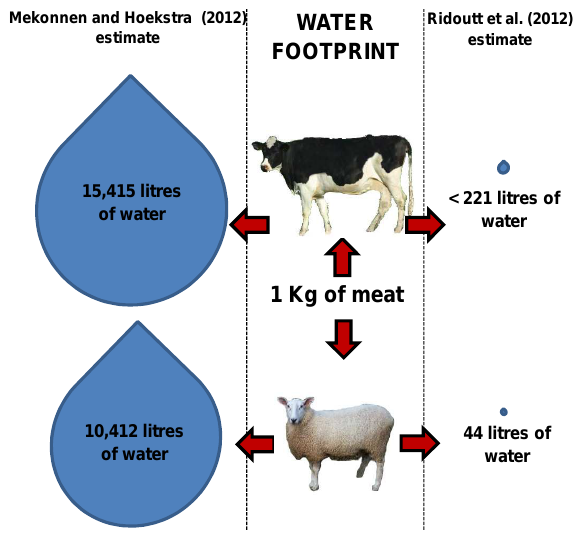
Figure 3. A comparison of the water footprints for beef and lamb calculated by Mekonnen and Hoekstra (2012a) and Ridoutt et al. (2012a,b), illustrating clearly how different methodological ap- Figure 3: A comparison of the water footprints for beef and lamb calculated by Mekonnen 16 proaches for calculating a water footprint can produce starkly dif- and Hoekstra (2012a) and Ridoutt et al (2012a) and Ridoutt et al (2012b), illustrating clearly 17 ferent how different methodological approaches for calculating a water footprint can produce starkly 18 different results. 19